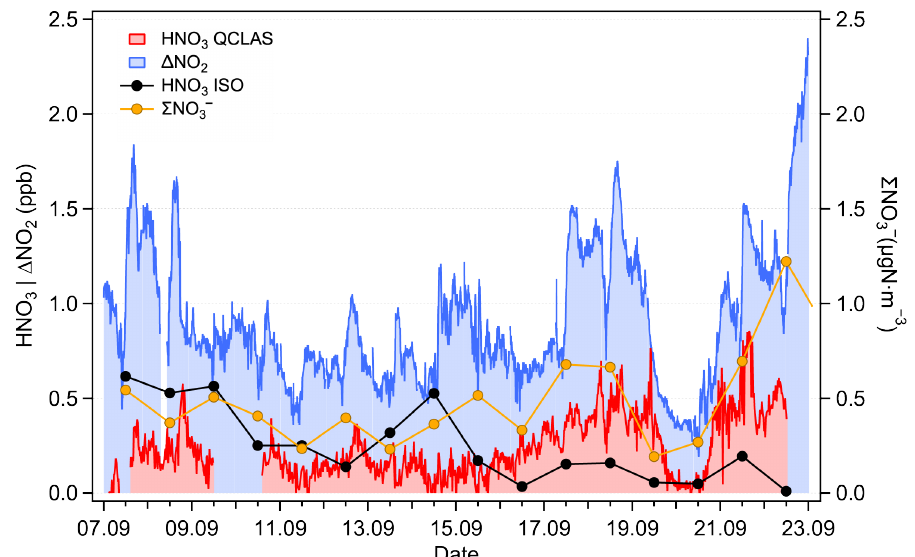
Figure 8. Time series of HNO measured by the QCLAS (red) and estimated using the ISORROPIA 3 model (black), Σ NO − (orange) and the difference in NO 3 instruments ( ∆ NO , 2